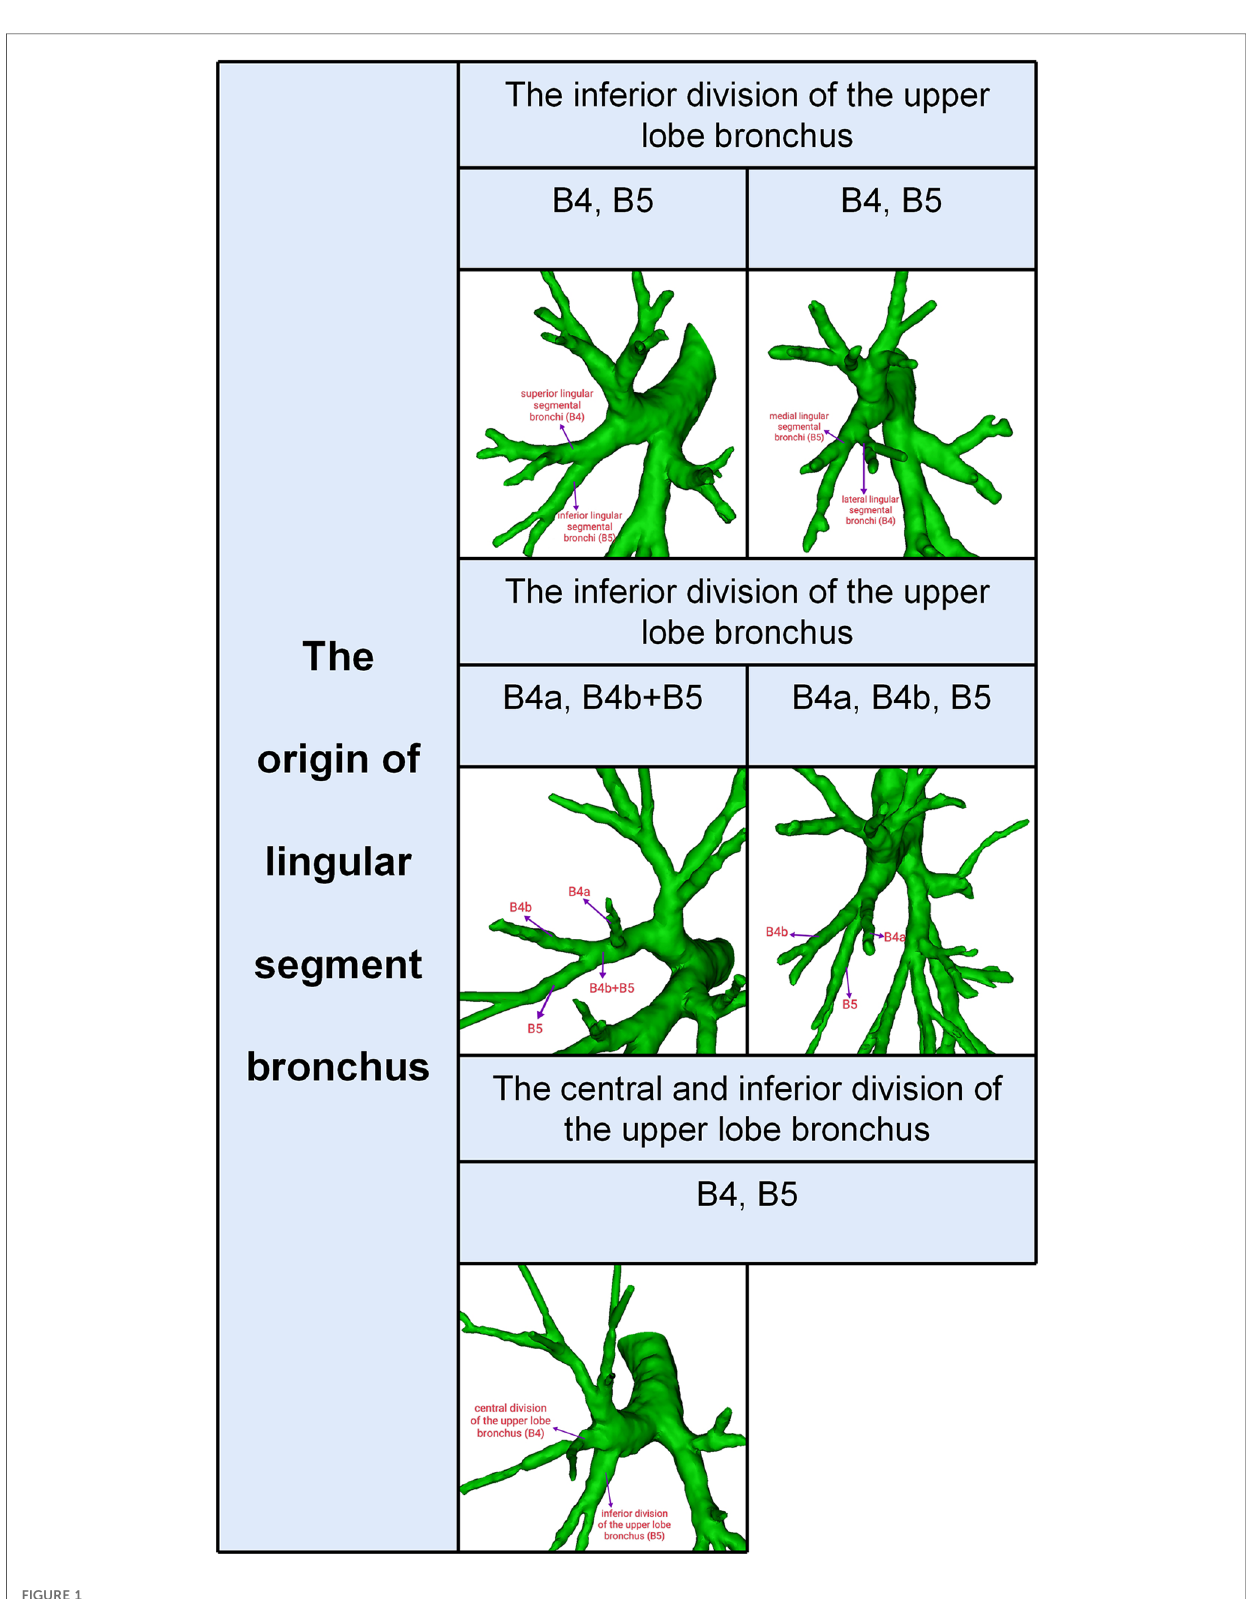
FIGURE 1 3D reconstruction model of branching patterns of the lingular segment